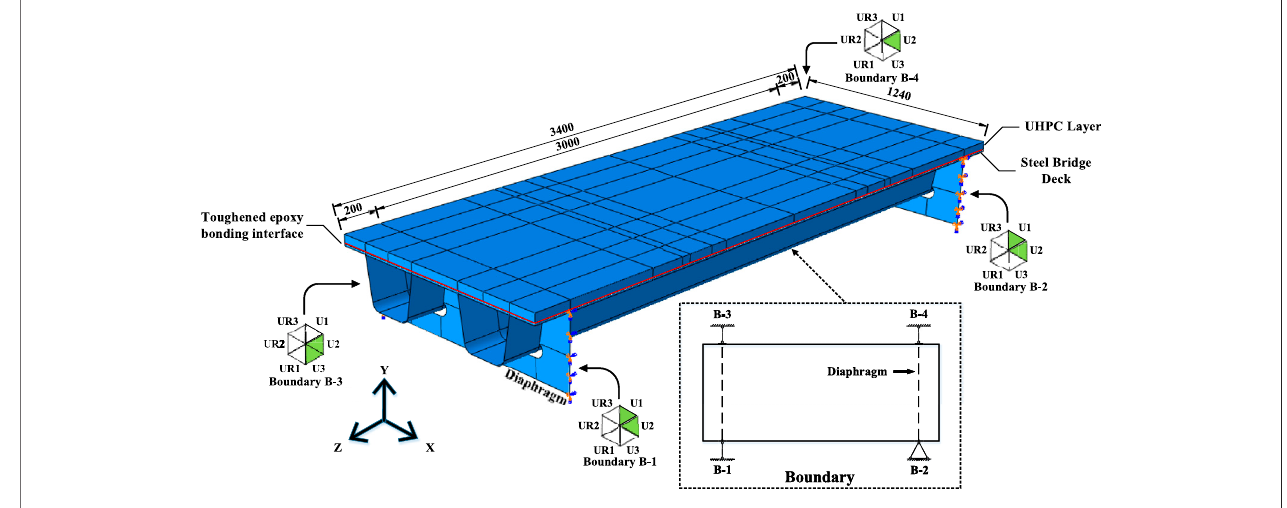
FIGURE 8 | ABAQUS fi nite element model.